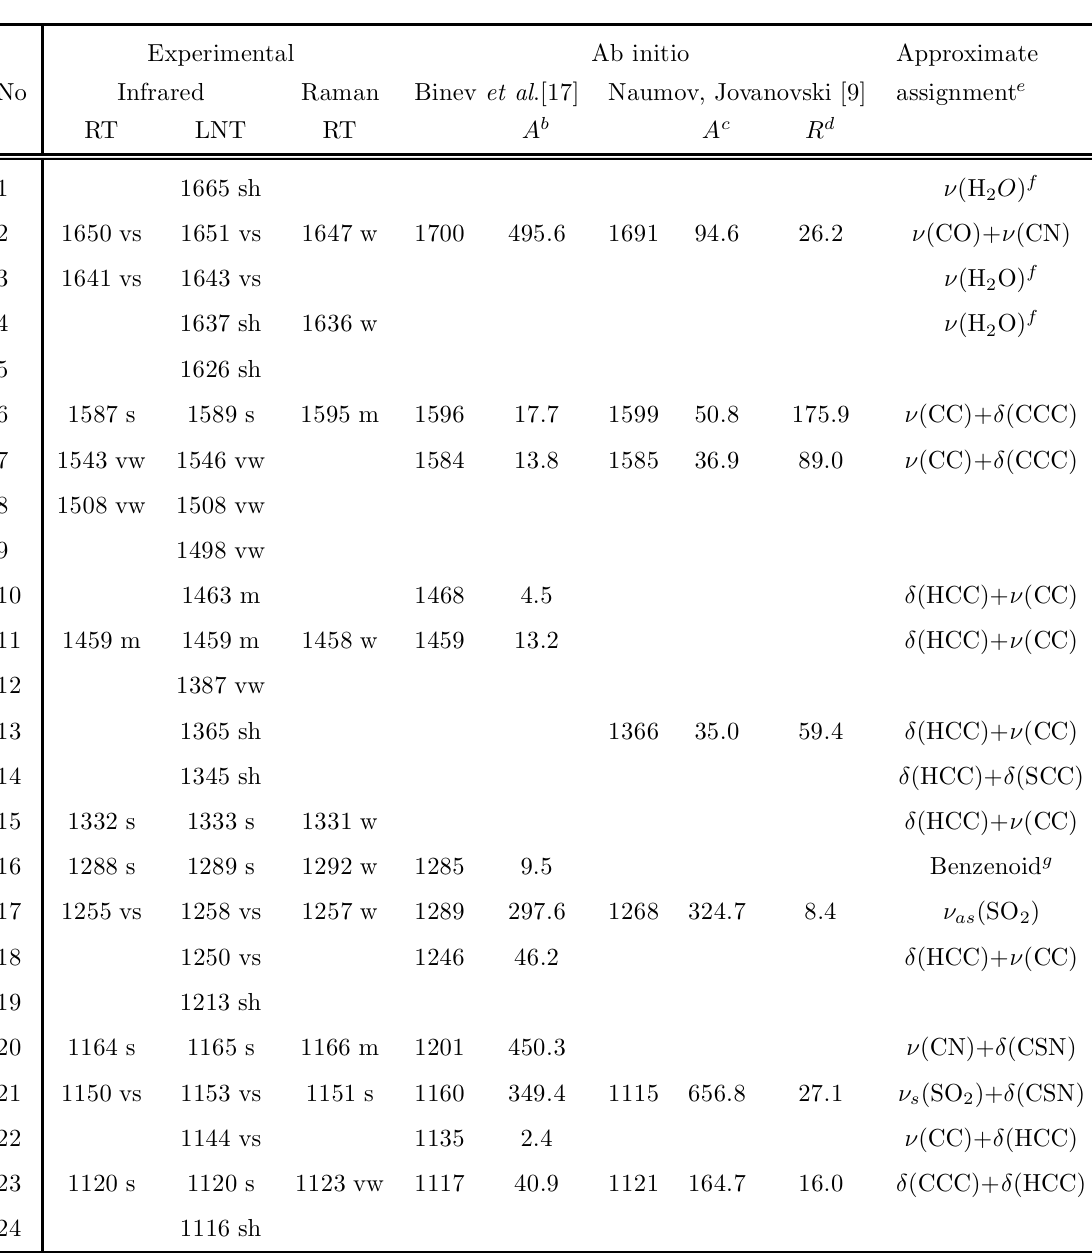
Table 5 Assignment of the experimental frequencies in the infrared and Raman spectra of tripotassium trisaccharinate dihydrate based on the literature theoretical infrared and Raman data for deprotonated saccharin (saccharin anion) in the 1700-1100 cm ¡ 1 region a